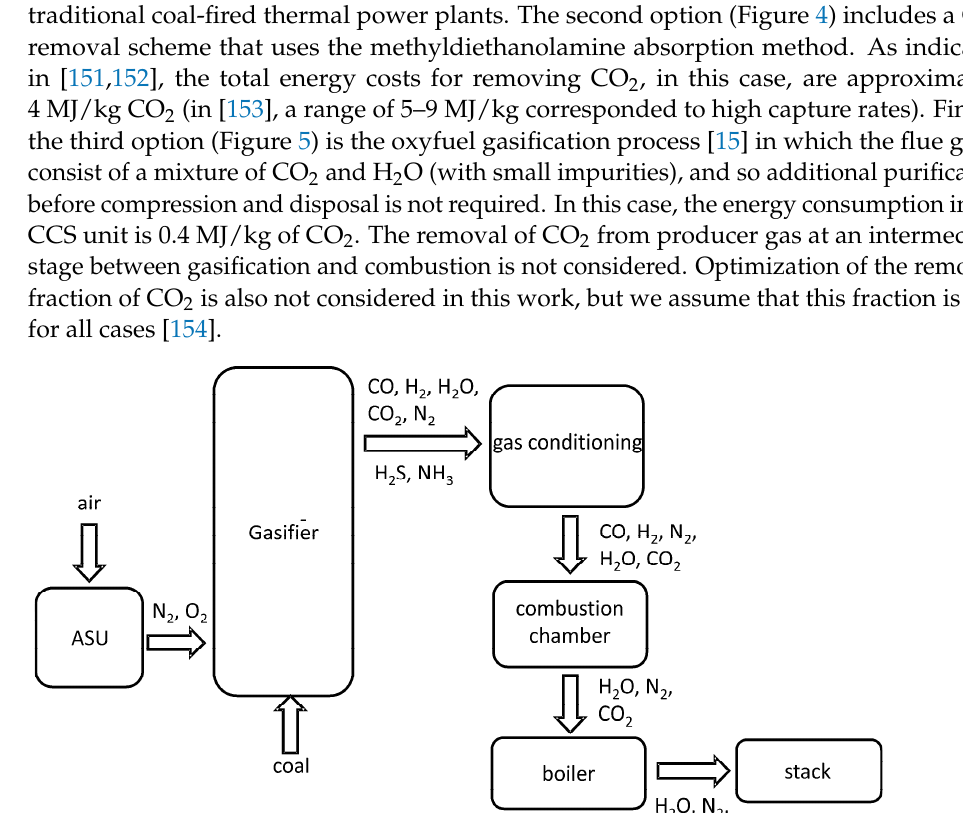
Figure 4. Scheme of a coal-fired IGCC plant with the removal of CO 2 from flue gases. Figure 5. Scheme of a coal-fired IGCC in oxyfuel mode.